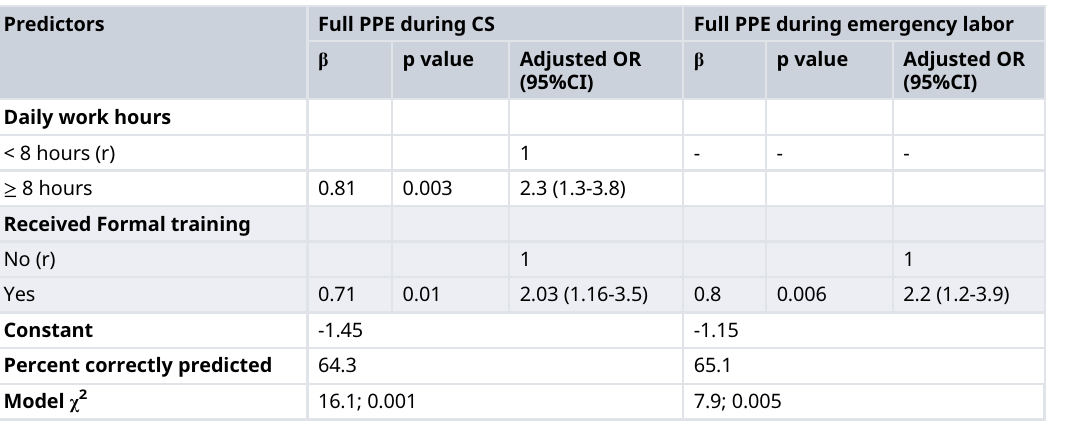
Table 2. Logistic regression analysis for predictors of full PPE use during CS.